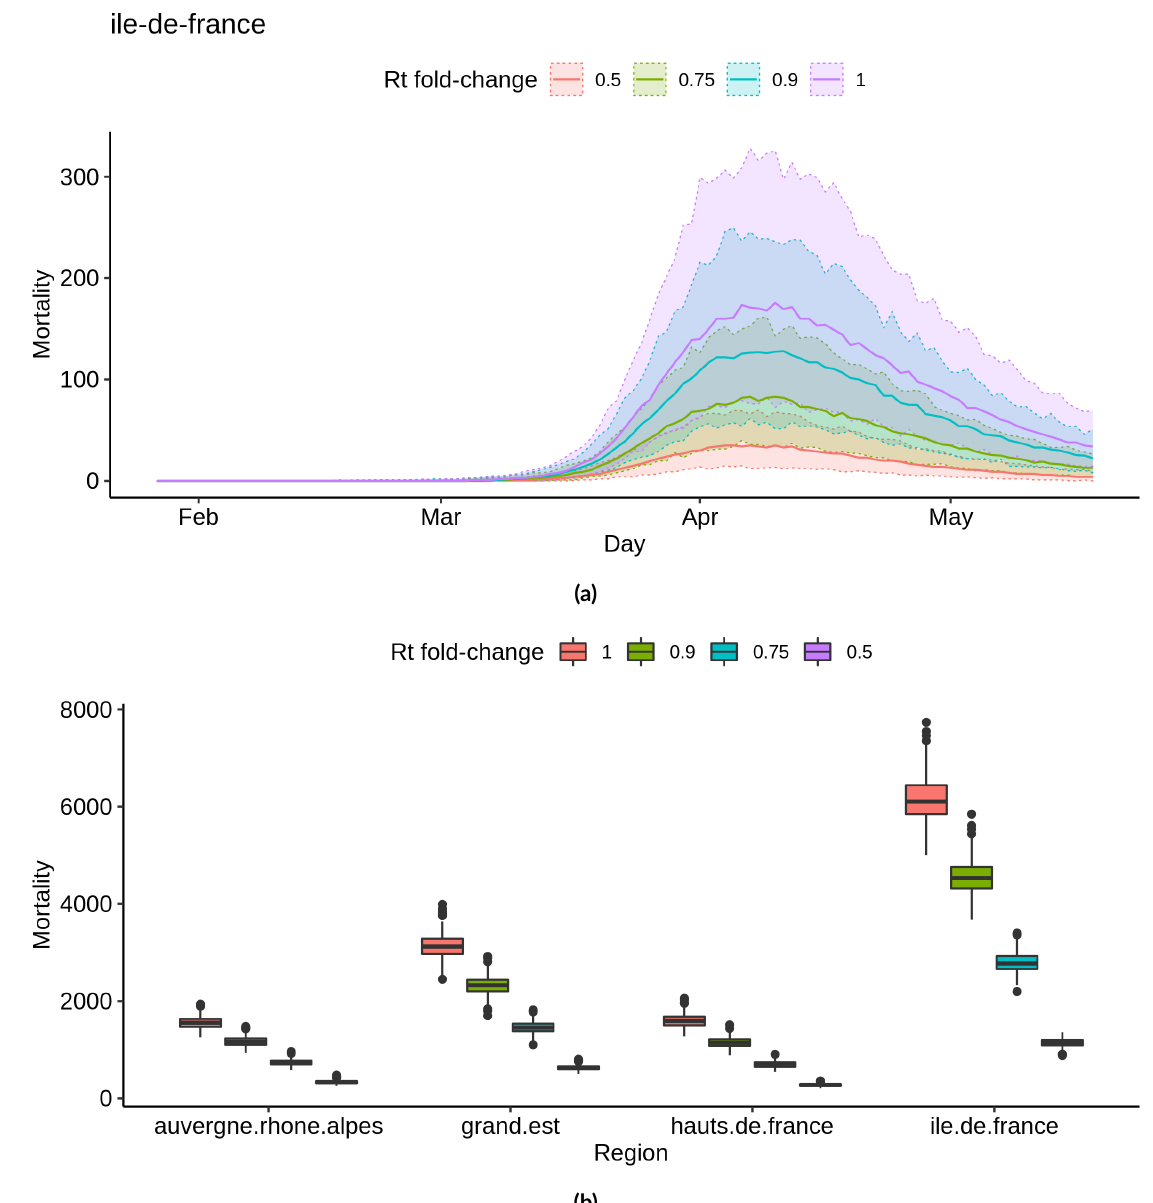
Figure 6 – Simulated distributions of deaths, assuming different effect sizes of week-ends on R t . (a) Simulated distribution of deaths through time in region Île-de-France. Median values are represented with a solid line, and shaded areas correspond to 95% credibility intervals. (b) Distributions of the total numbers of deaths in four regions. Each box shows (from top to bottom) the 3rd quartile, median and 1st quartile of the distribution. The vertical line on top of each box extends up to the largest value of the sample no further from the 3rd quartile than 1.5 times the inter-quartile difference; larger values are then represented as dots and can be interpreted as possible outliers. The vertical lines below each box are constructed in an analogous way for low